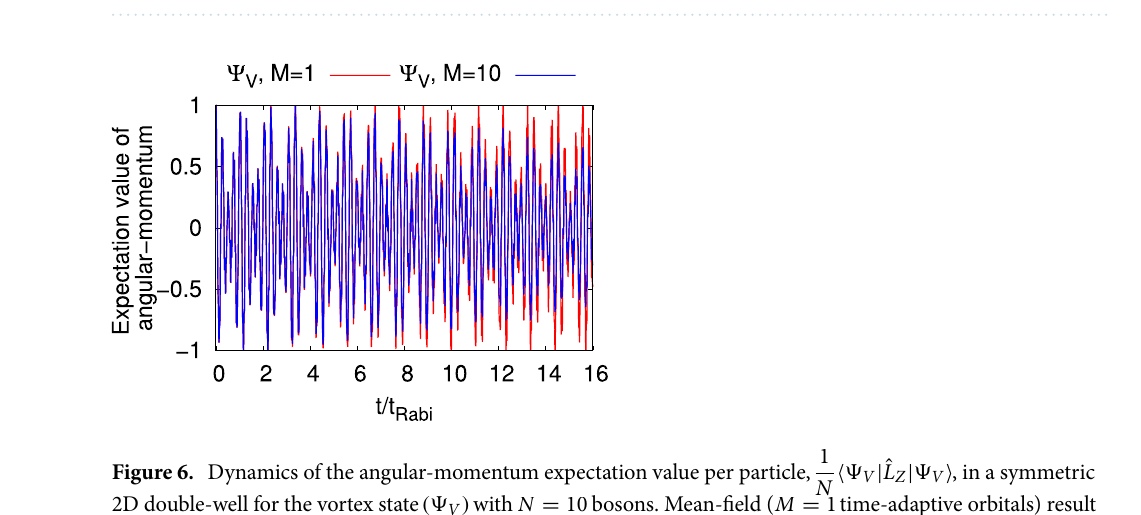
Table 1. Expectation values of the observables and their variances at t = 0 . See the text for more details. The quantities shown are dimensionless.